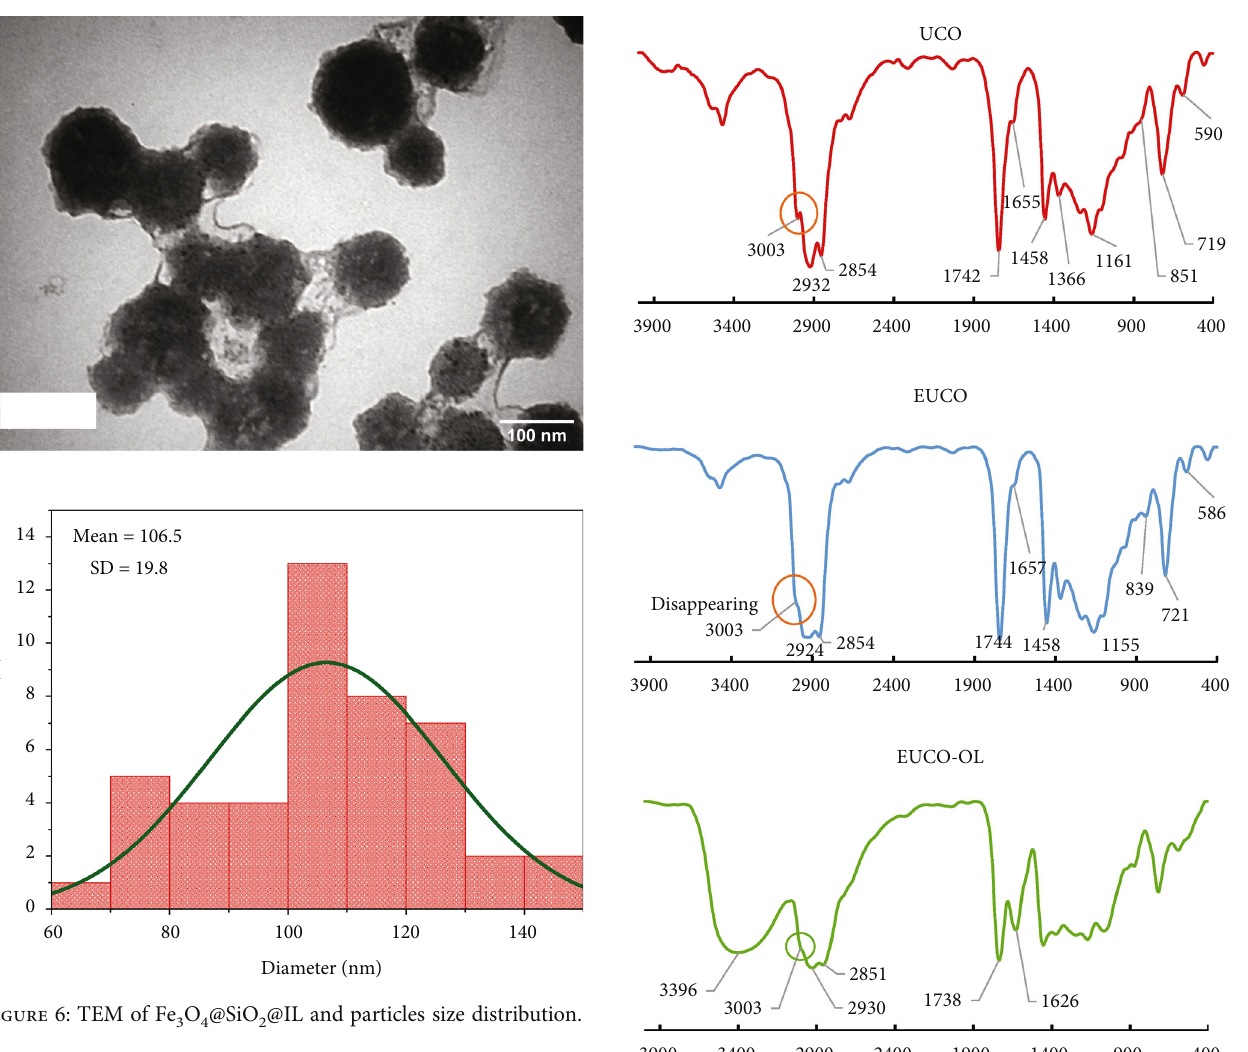
O @SiO @IL and particles size distribution. 3 4 2